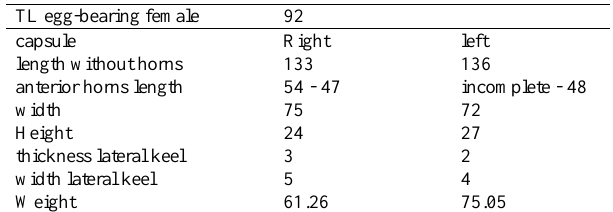
Table 2. Measurements (mm) recorded for a pair of egg cap- sules of Dipturus chilensis ; length without horns; anterior horns’ length; capsule width and height, thickness and width of the lateral keel and capsule weight (g). Total length range of the egg-bearing female from which the pair of egg capsules was extracted (TL ) is indicated.